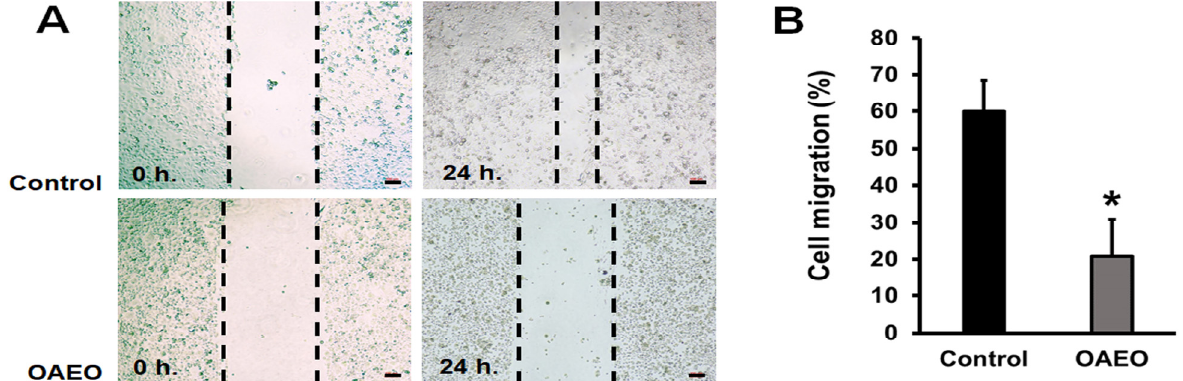
Figure 3. Effect of OAEO on AGS cell migration as determined by in vitro wound-healing assay. ( A ) Representative images of the initial wound area (0 h) and the remaining cell-free area (24 h) in OAEO-treated and vehicle control cultures. ( B ) Rates of cell migration (%) were quantified by comparing the wound area before and after treatment. Data are presented as mean ± standard deviation from triplicate experiments. * p < 0.05 vs the vehicle control group.